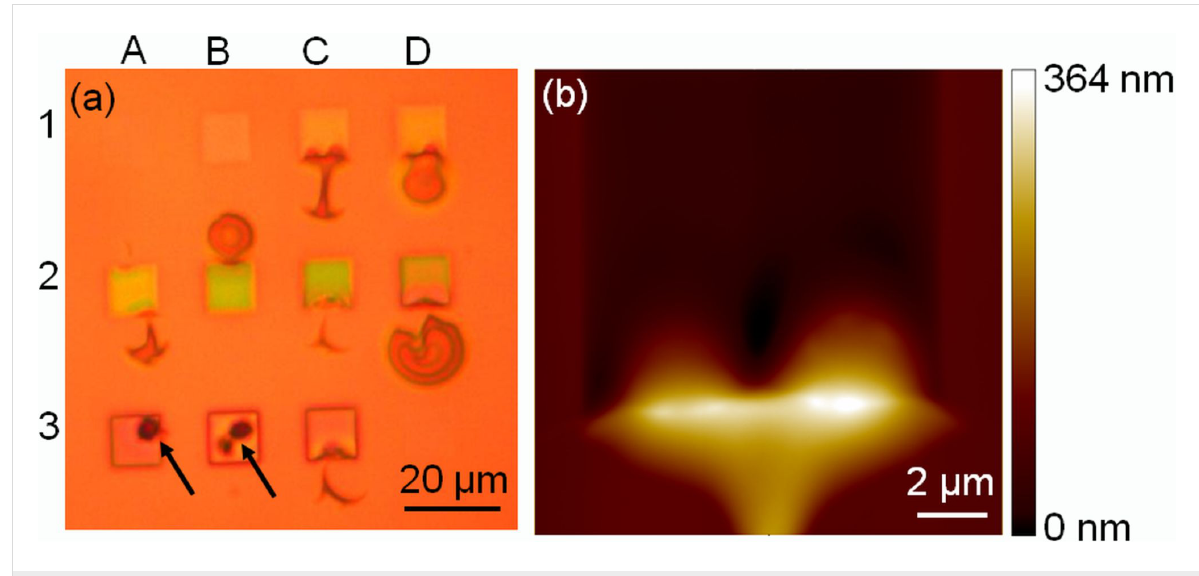
Figure 4: (a) Optical micrograph of an array of squares produced with He + /25 keV FIB in a 15 nm Au/200 nm PMMA sample. The irradiation fluence increases in the following raster scan order: A1 (3.3 × 10 13 cm − 2 ), B1 (2.0 × 10 14 cm − 2 ), C1 (3.7 × 10 14 cm − 2 ), D1 (5.3 × 10 14 cm − 2 ), A2 (1.0 × 10 15 cm − 2 ), B2 (2.0 × 10 15 cm − 2 ), C2 (2.5 × 10 15 cm − 2 ), D2 (5.1 × 10 15 cm − 2 ), A3 (7.6 × 10 15 cm − 2 ), B3 (1.0 × 10 16 cm − 2 ), C3 (1.3 × 10 16 cm − 2 ), and D3 (3.3 × 10 13 cm − 2 ). The lowest fluence (3.3 × 10 13 cm − 2 ) was irradiated in cells A1 and D3 to control the reproducibility of the obtained results. Black arrows indicate the holes in the Au film in the irradiated regions. (b) AFM image of the C1